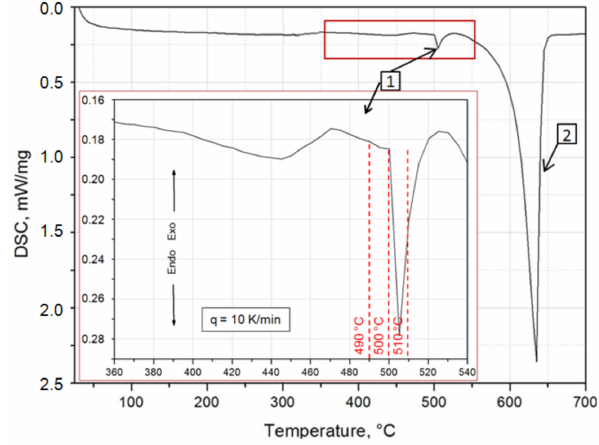
Figure 2. Thermogram (DSC) obtained during the heating of the 2017A alloy from room temperature to 700 ◦ C at a rate of 10 ◦ C/min with an enlarged section of the thermogram in the temperature range of 360 ◦ C to 540 ◦ C. The peak denoted as (1) is the result of the dissolution of the intermetallic phases occurring in the form of eutectics, and the peak dented as (2) is the effect of dissolving a solid α -Al solution.